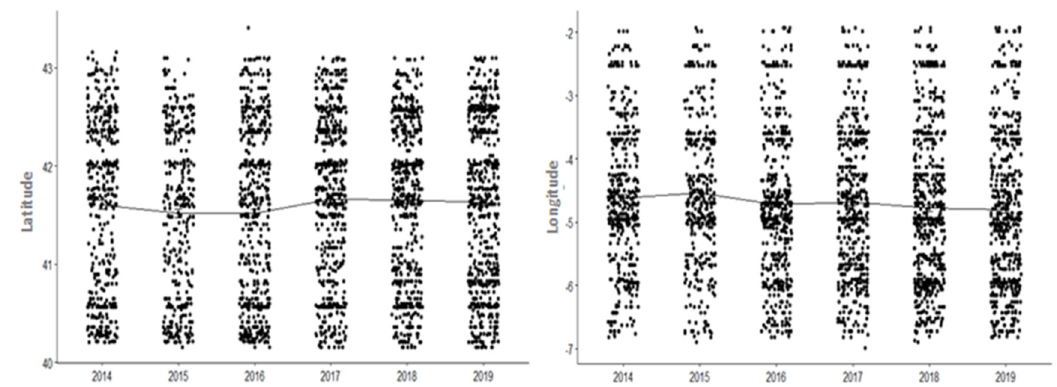
Figure 6. Longitudinal and latitudinal patterns over time.